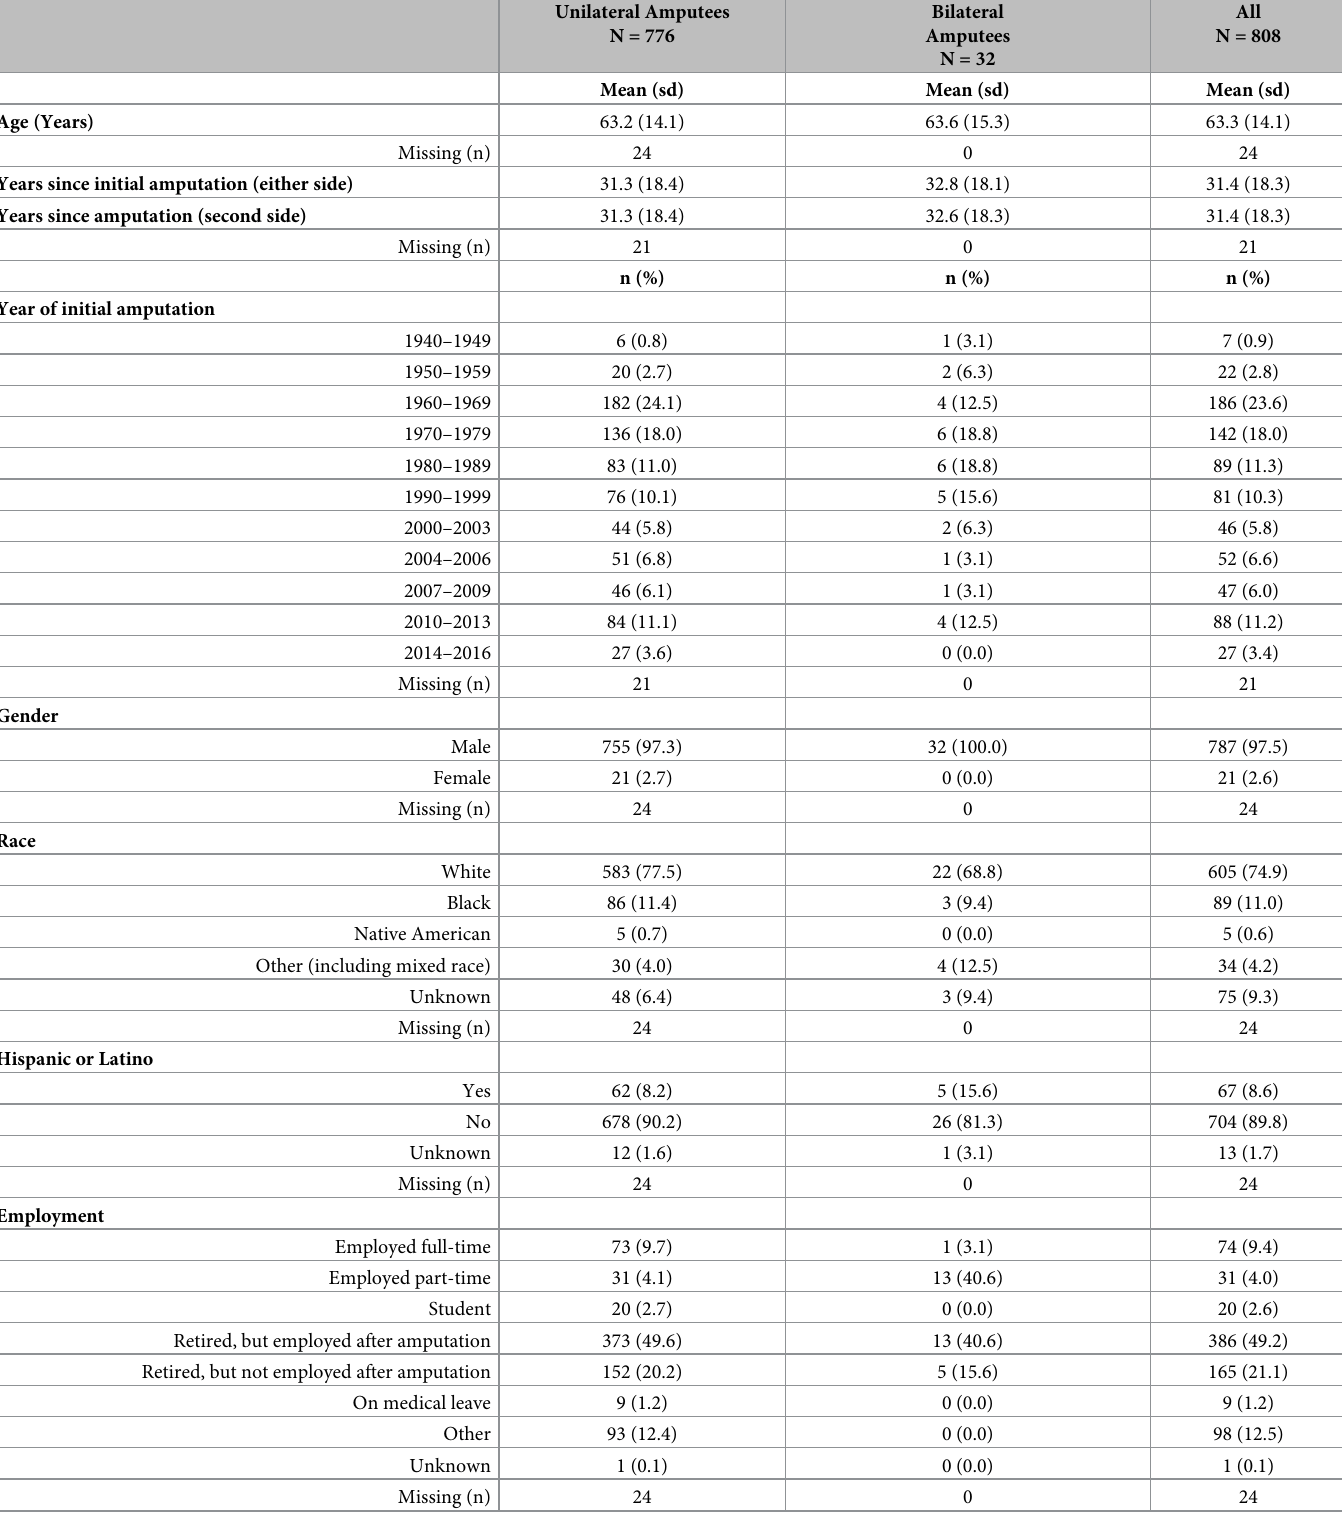
Table 2. Demographics characteristics of unilateral and bilateral amputee